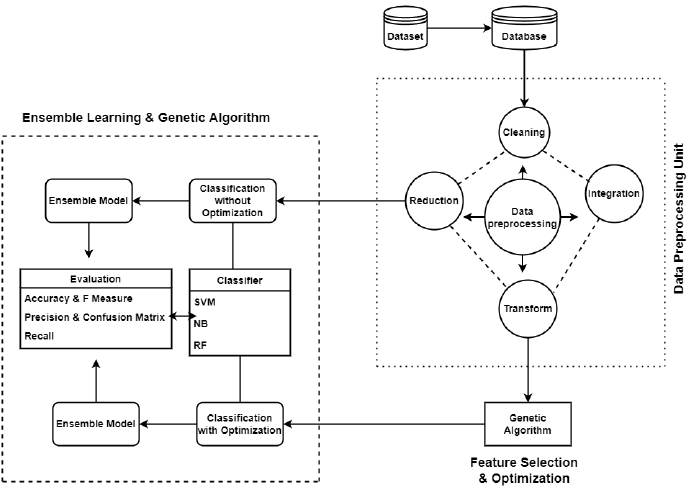
Figure 1. Proposed